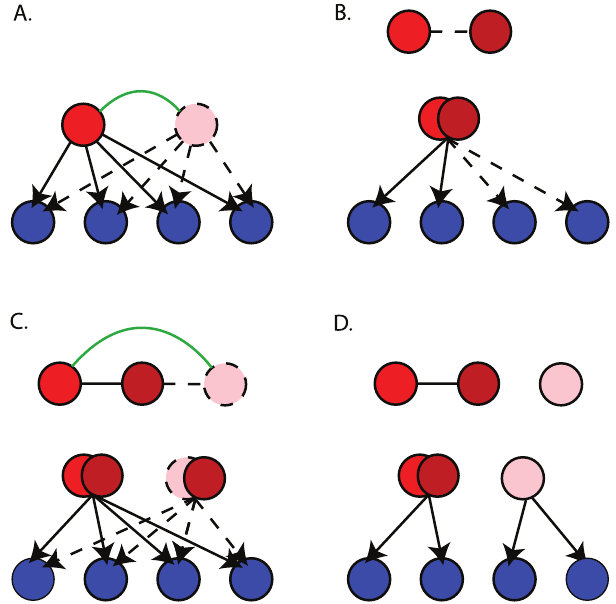
Figure 2. Growth Models for Formation of Bi-Fan Arrays Nodes originating from gene duplication are connected by green undirected edges. Black undirected edges represent protein–protein interactions, and dotted edges/nodes represent network components gained with respect to time. (A) Simple gene duplication scenario results in formation of bi-fan array regulated by homologous TFs. (B) Nonhomologous TFs form bi-fan arrays by accumulation of common target genes. A low-affinity protein–protein interaction between the TFs allows combinatorial control of targets. (C) Duplication of one component of a regulatory complex leads to creation of two regulatory complexes. Conservation of protein–protein interactions creates nonhomologous bi-fan arrays originating from gene duplication. (D) The loss of one of the protein–protein interactions between duplicated TFs and their common binding partner in (C) has the potential to create binding diversity in homologous TFs.